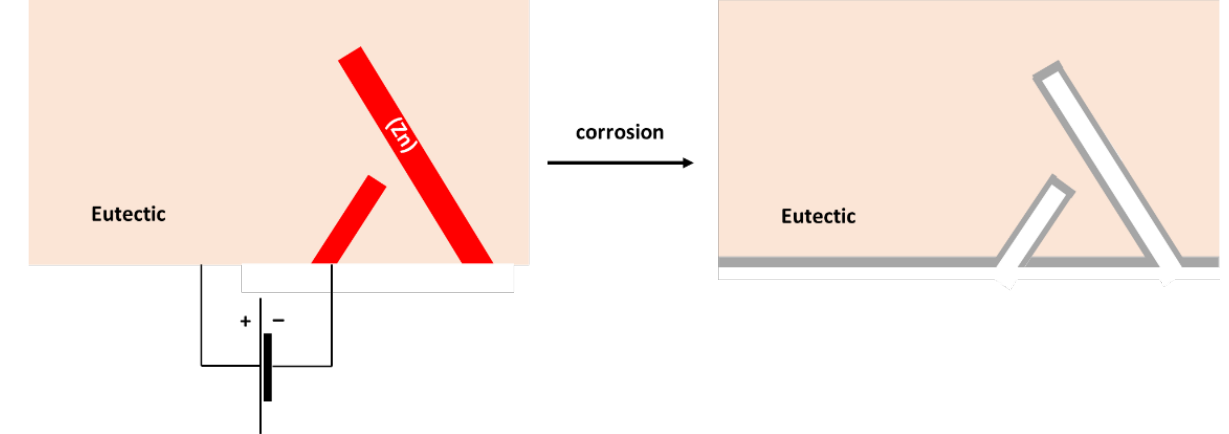
Figure 11. Schematic of microgalvanic cell formation in the Sn–15Zn alloy. The chemical composition of the corrosion products formed on the Sn–Zn alloys changed with increasing Zn weight fraction (Table 3). Alloys with a higher concentration of Zn (Sn–9Zn, Sn–15Zn and Zn) formed corrosion products with a high Zn atomic fraction. Zinc is prone to anodic dissolution according to the following reaction